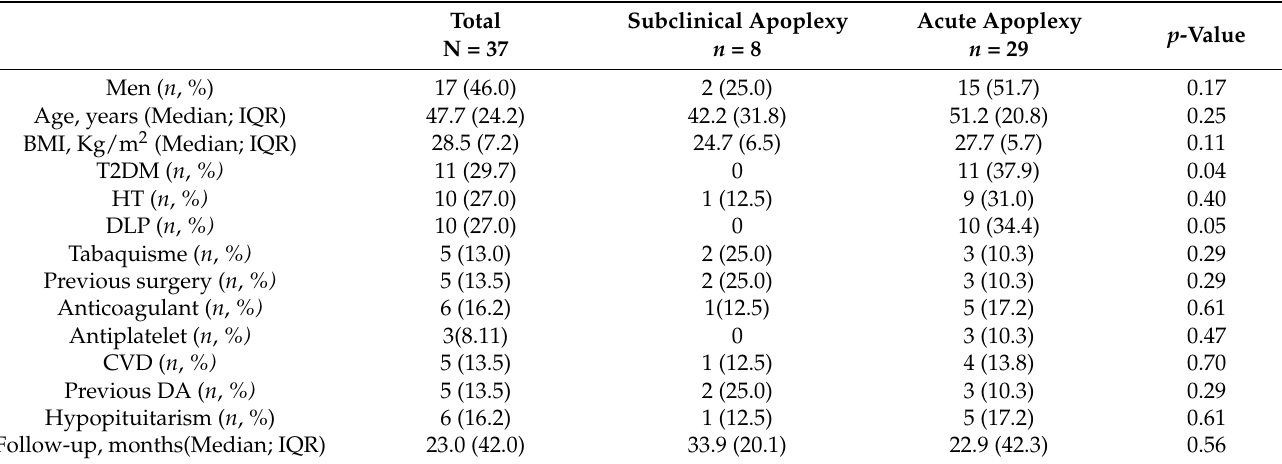
Table 1. Baseline demographic, clinical history, and risk factors of the different types of pituitary apoplexy.